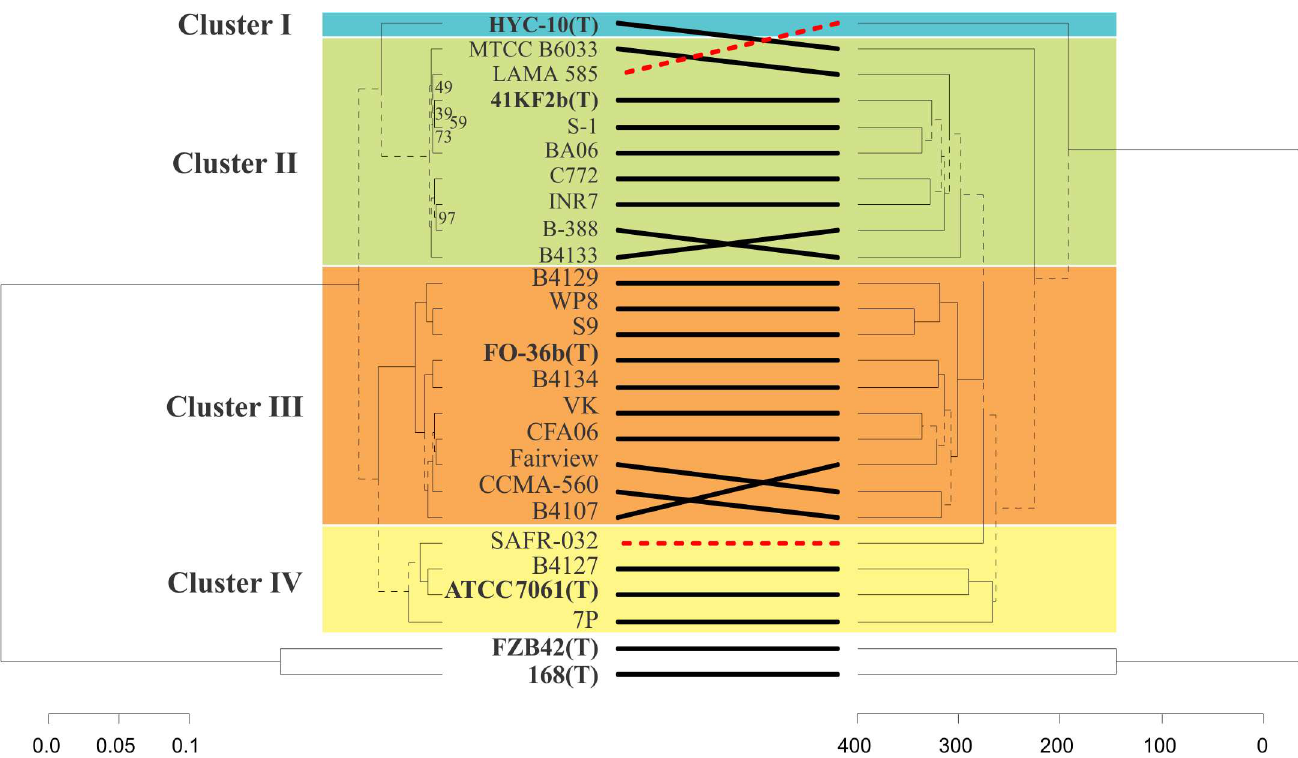
Fig 3. Comparison of phylogenomic and functional dendrograms of Bacillus pumilus group strains. Phylogenomic and functional dendrogram comparisons were performed and plotted with the R package “dendextend” [28]. A) Phylogenomic dendrogram . 109 BLAST core genes were individually aligned, concatenated and trimmed resulting in a final alignment containinga total of 104022residues. The evolutionaryhistory of the indicated strains was inferred with RAxML algorithm [24]. Reliability of the inferred tree was tested by bootstrapping with 1000 replicates. When not indicated, the bootstrap support values were 100. B) Functionaldendrogram .Biologicalfunctions of proteins encodedin the genomeof the indicated strain (Types in bold) were inferred using the OrthoMCL software [26] and then used as a binary score for hierarchical cluster analysis implemented with the R package “pvcluster”